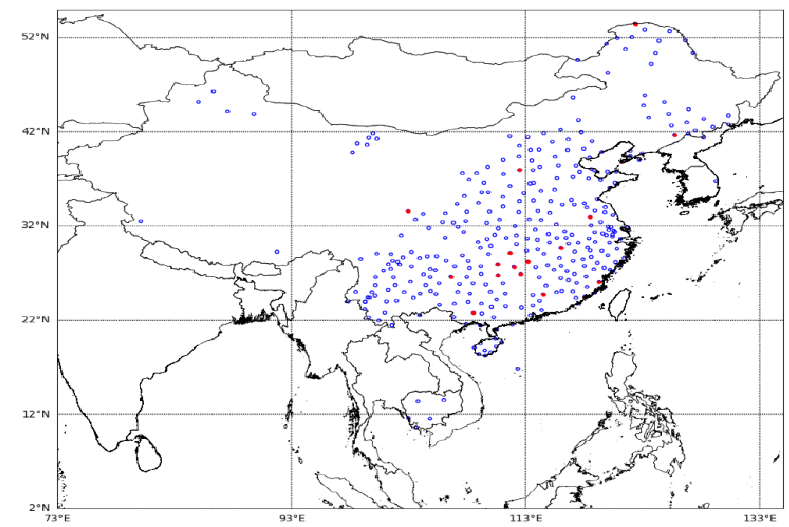
Figure 2. Map of lightning detection sites. The blue circle represents a regular site, and the red circle represents a waveform acquisition site.